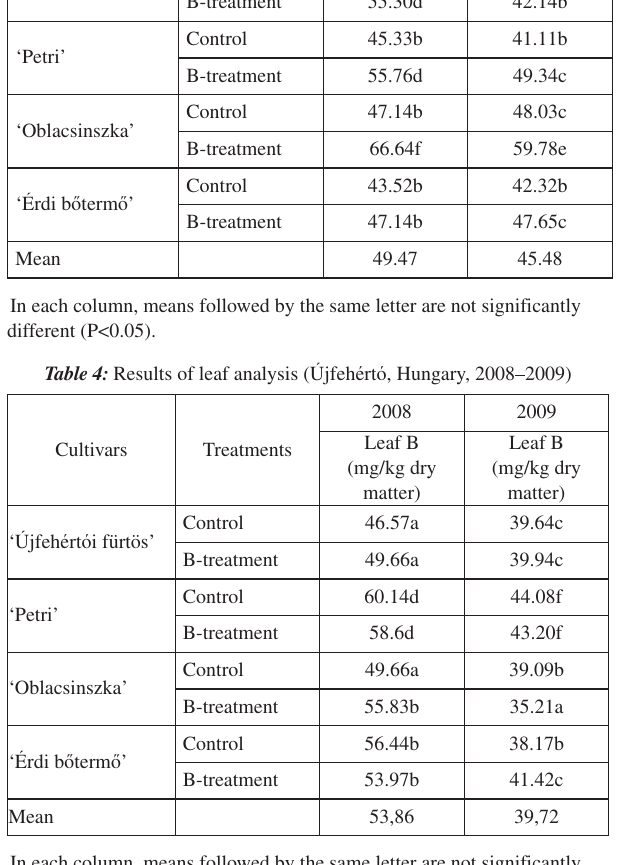
Table 5: Results of fruit analysis I. (organic acids) (Újfehértó, Hungary, 2008)